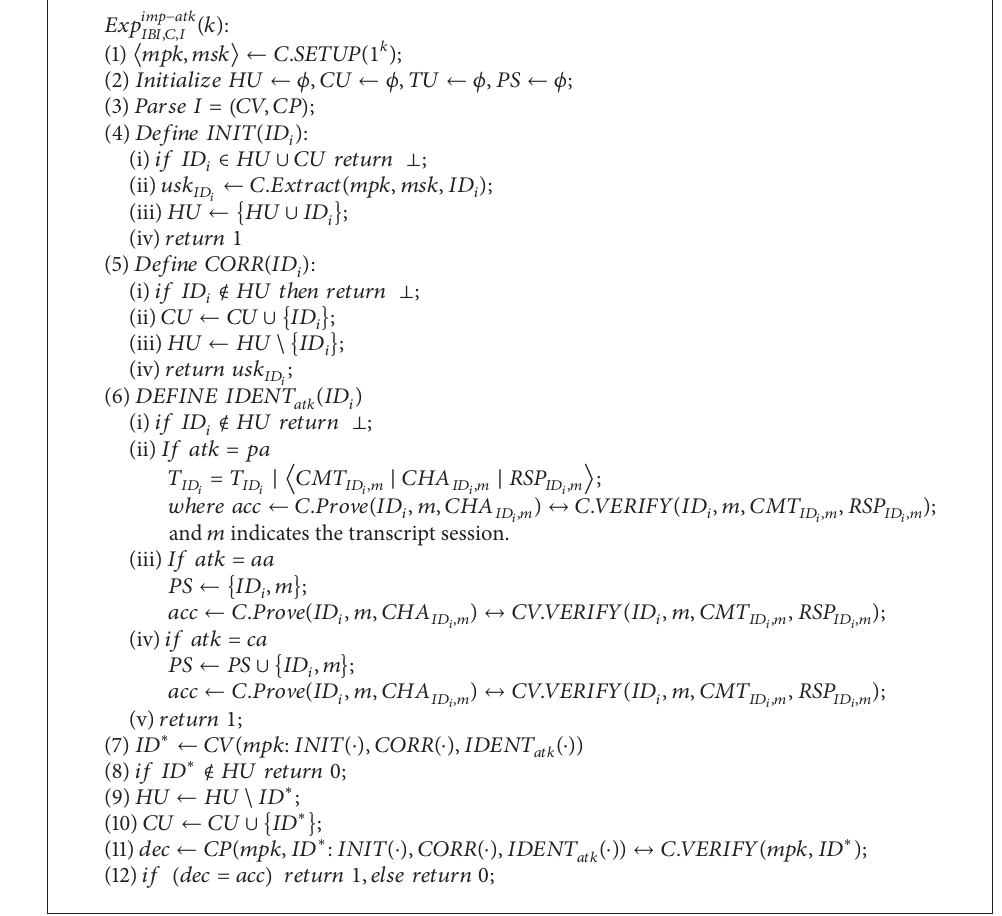
Algorithm 2: Description of the security model for IBI